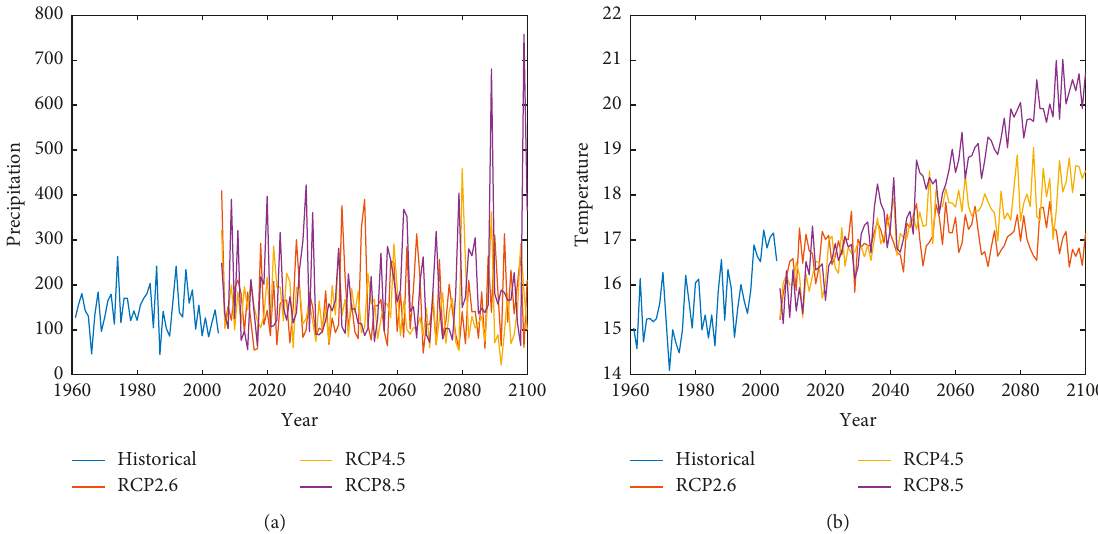
Figure 3: Comparison of precipitation (a) and temperature (b) observed and modeled under RCP scenarios during the period 1961–2100.